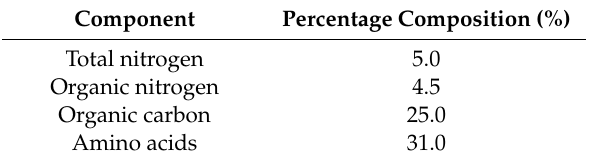
Table 7. Composition of P-PH tested (TYSON ® , Mugavero fertilizers, Italy, Palermo). Component